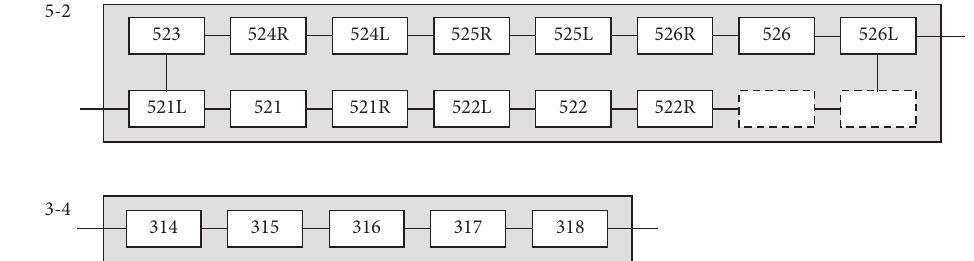
Figure 4: Nodes connection relationship in a